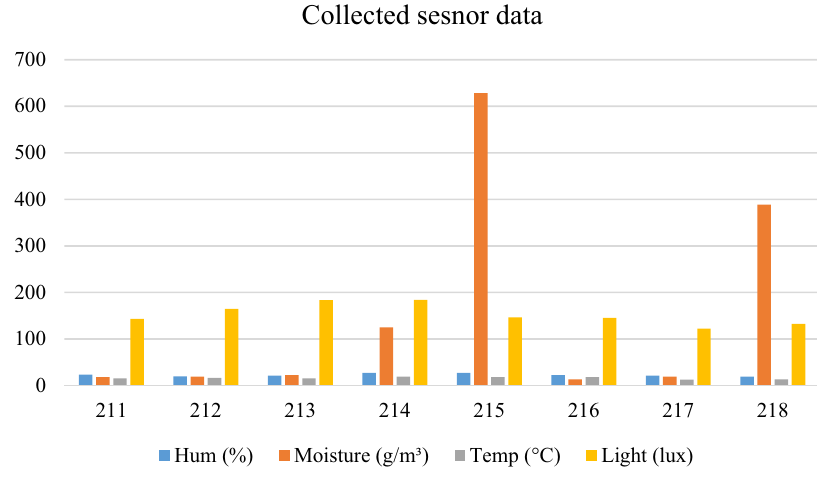
Figure 5: Collected sensor information in IoT cloud during